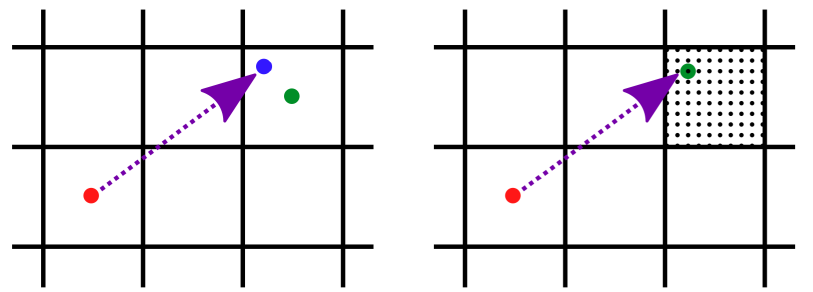
Figure 3. Purple arrow represents the step from the red point. Left figure shows that in the grid filter, the next position is estimated at the green point in the grid cell center point instead of the true location denoted by the blue point. In the centroid grid filter (figure on the right), the next position is chosen from the set of fine grid